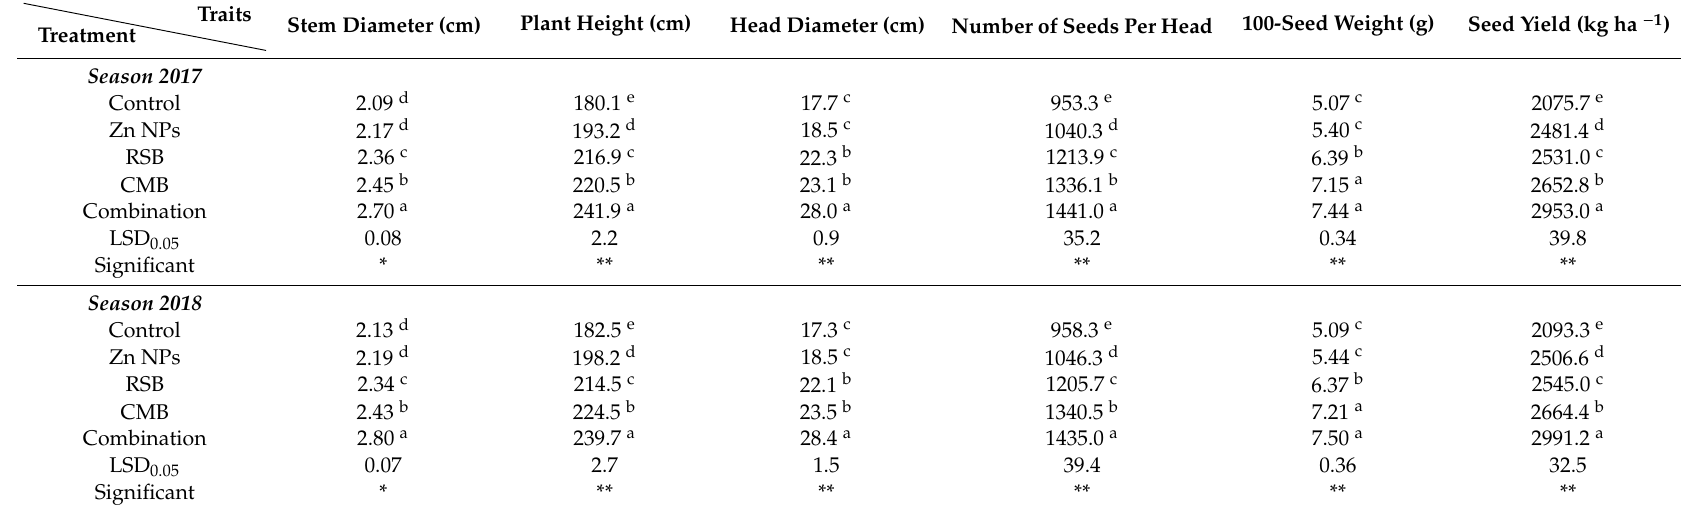
Table 2. E ff ects of zinc nano-particles, plant-, and animal-biochars on growth, and yield and its components of sunflower grown in soil irrigated with wastewater over the